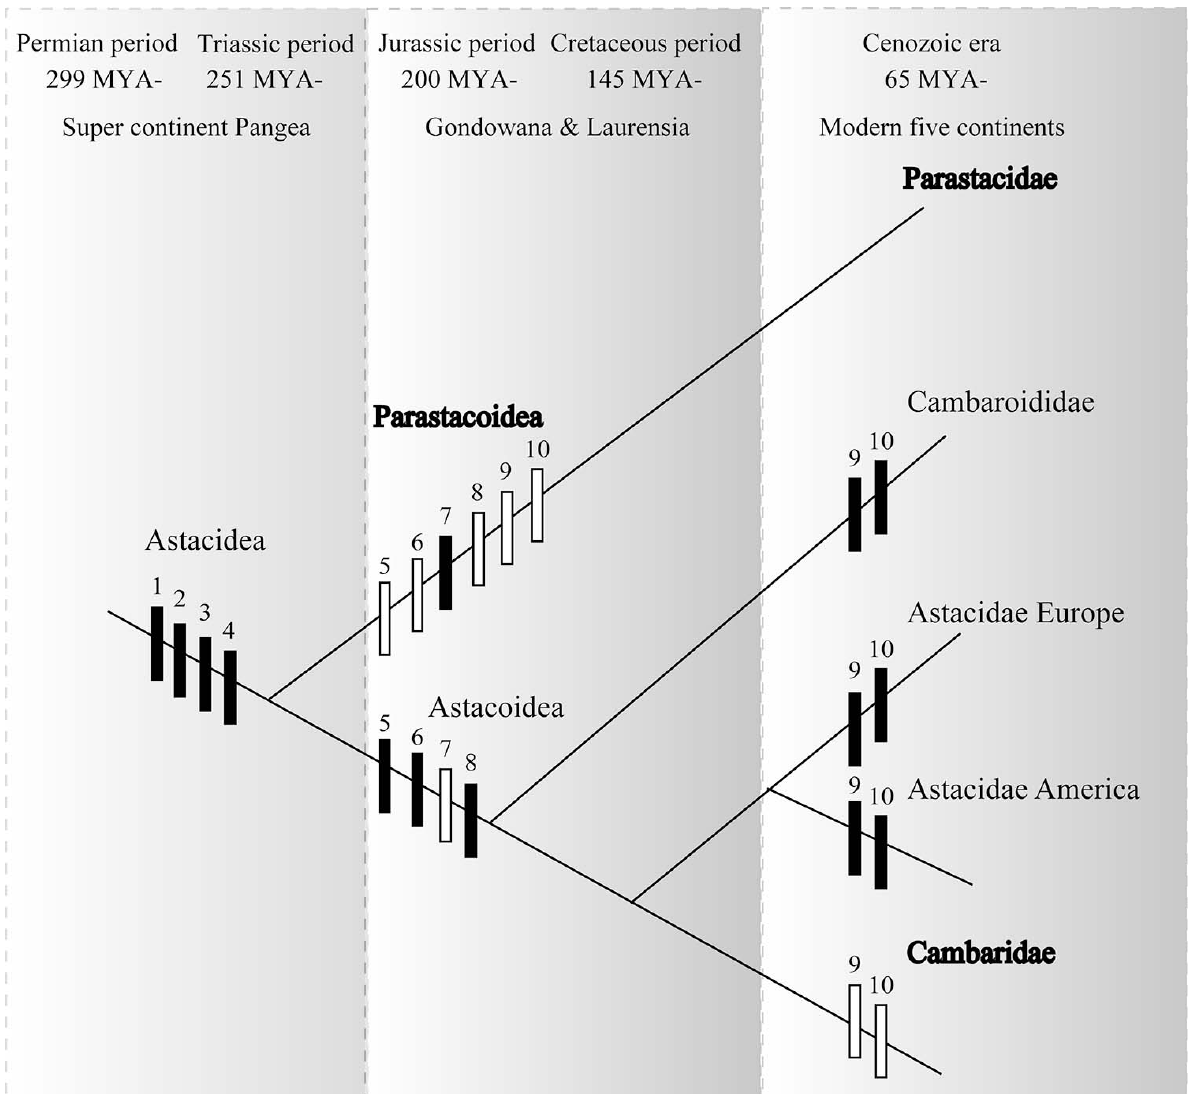
Figure 26. Estimate of the evolution of maternal care and accompanying postembryonic development in freshwater crayfish (Astacidea) based on juvenile morphology. The tree is based on other recent molecular phylogenetic trees (Crandall et al. , 2000; Porter et al. , 2005; Bracken et al. , 2009; Breinholt et al. , 2009; Pérez-Losada et al. , 2010; Stern and Crandall, 2016; Crandall and De Grave, 2017; Grandjean et al. , 2017) and molecular clocks (Toon et al. , 2010; Wolfe et al. , 2019). Juvenile morphology relating to maternal care (Tab. 5) is shown on the tree. The geological ages and formation of the continents is based on Owen (1976) and Dercourt et al. (1993). Solid bars indicate presence and blank bars absence. Numbers on the bar: 1: compound sessile eye in Stage I and developed eye stalk in Stage II; 2: globular carapace in Stage I lost in Stage II; 3: teeth and processes on mandible absent in Stage I but present in Stage II; 4: setae absent on pereiopod in Stage I but long setae present in Stage II; 5: no setae on antenna 1–2, with antennal scale in Stage I but seta present in Stage II; 6: no setae at tip of exopodite of maxilliped in Stage I, the plumose setae appear in Stage II; 7: curved hook at tip of the pereiopod present in Stage II; 8: plumose setae on telson in Stage II; 9: setae on maxilla 1 in Stage I; 10: no plumose setae on pleopod in Stage I but present in Stage II. Bold text (Cambaridae and Parastacidae): independent after Stage III; plain text (Astacidae and Cambaroididae): independent after Stage II (Andrews, 1907a; Albrecht, 1982; Scholtz, 1995; Scholtz and Kawai,